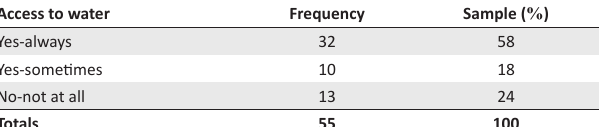
TABLE 2: Frequency distribution of residents’ access to water.